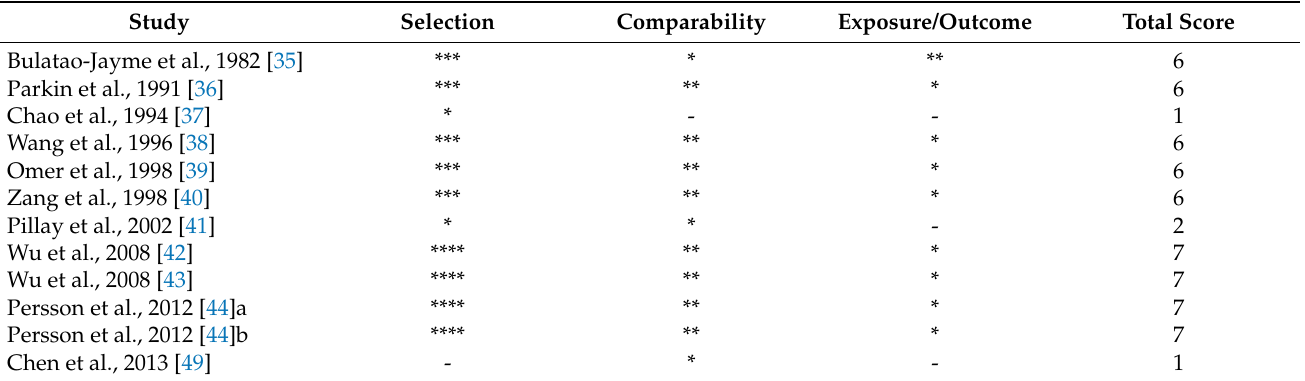
Table 2. Newcastle–Ottawa Scale quality assessment of each included